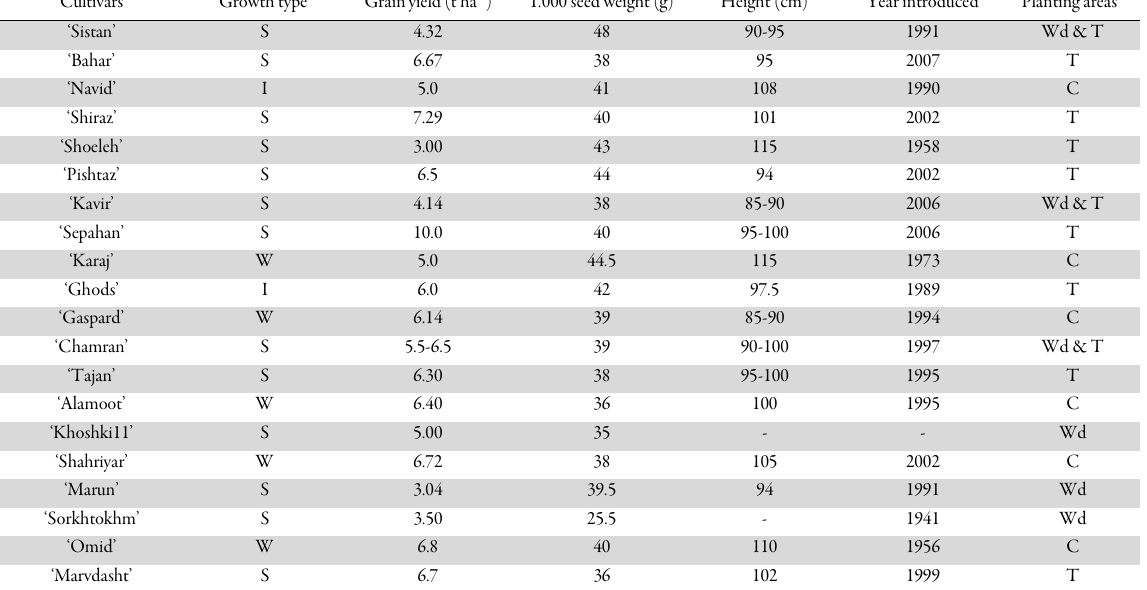
Table 1. Main characteristics of the investigated Iranian bread wheat cultivars